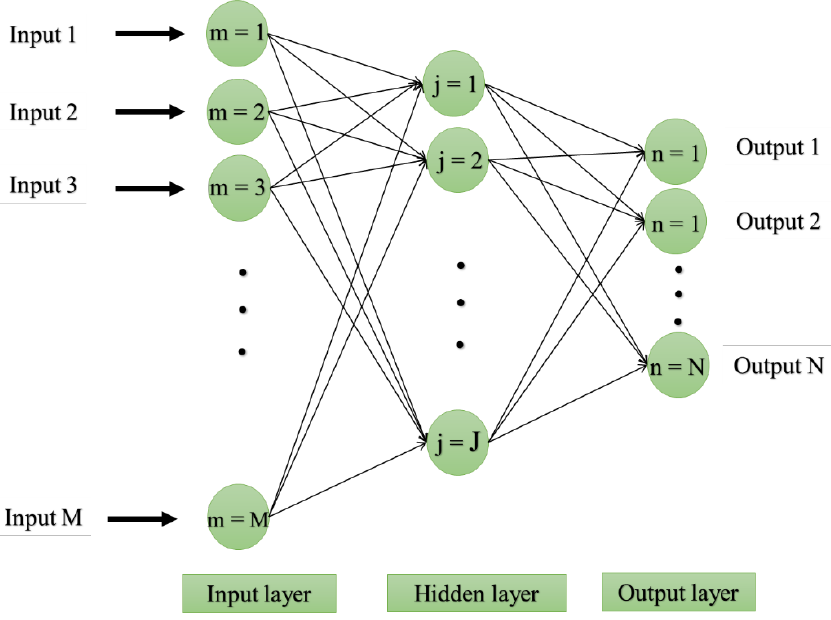
Figure 6. Typical multi-layer perceptron (MLP) structure.